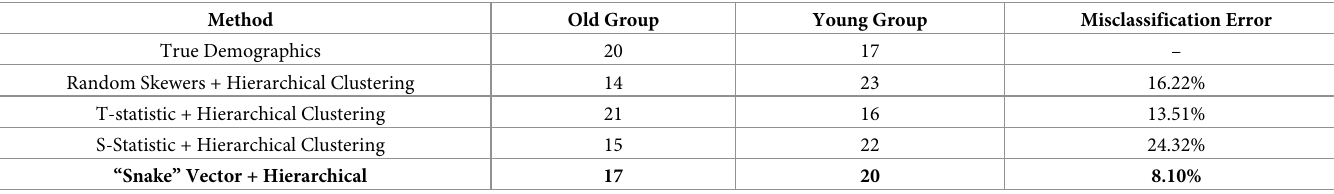
Table 1. Misclassification error of four clustering approaches in the pilot data set of brain connectivity matrices of young and old healthy subjects.